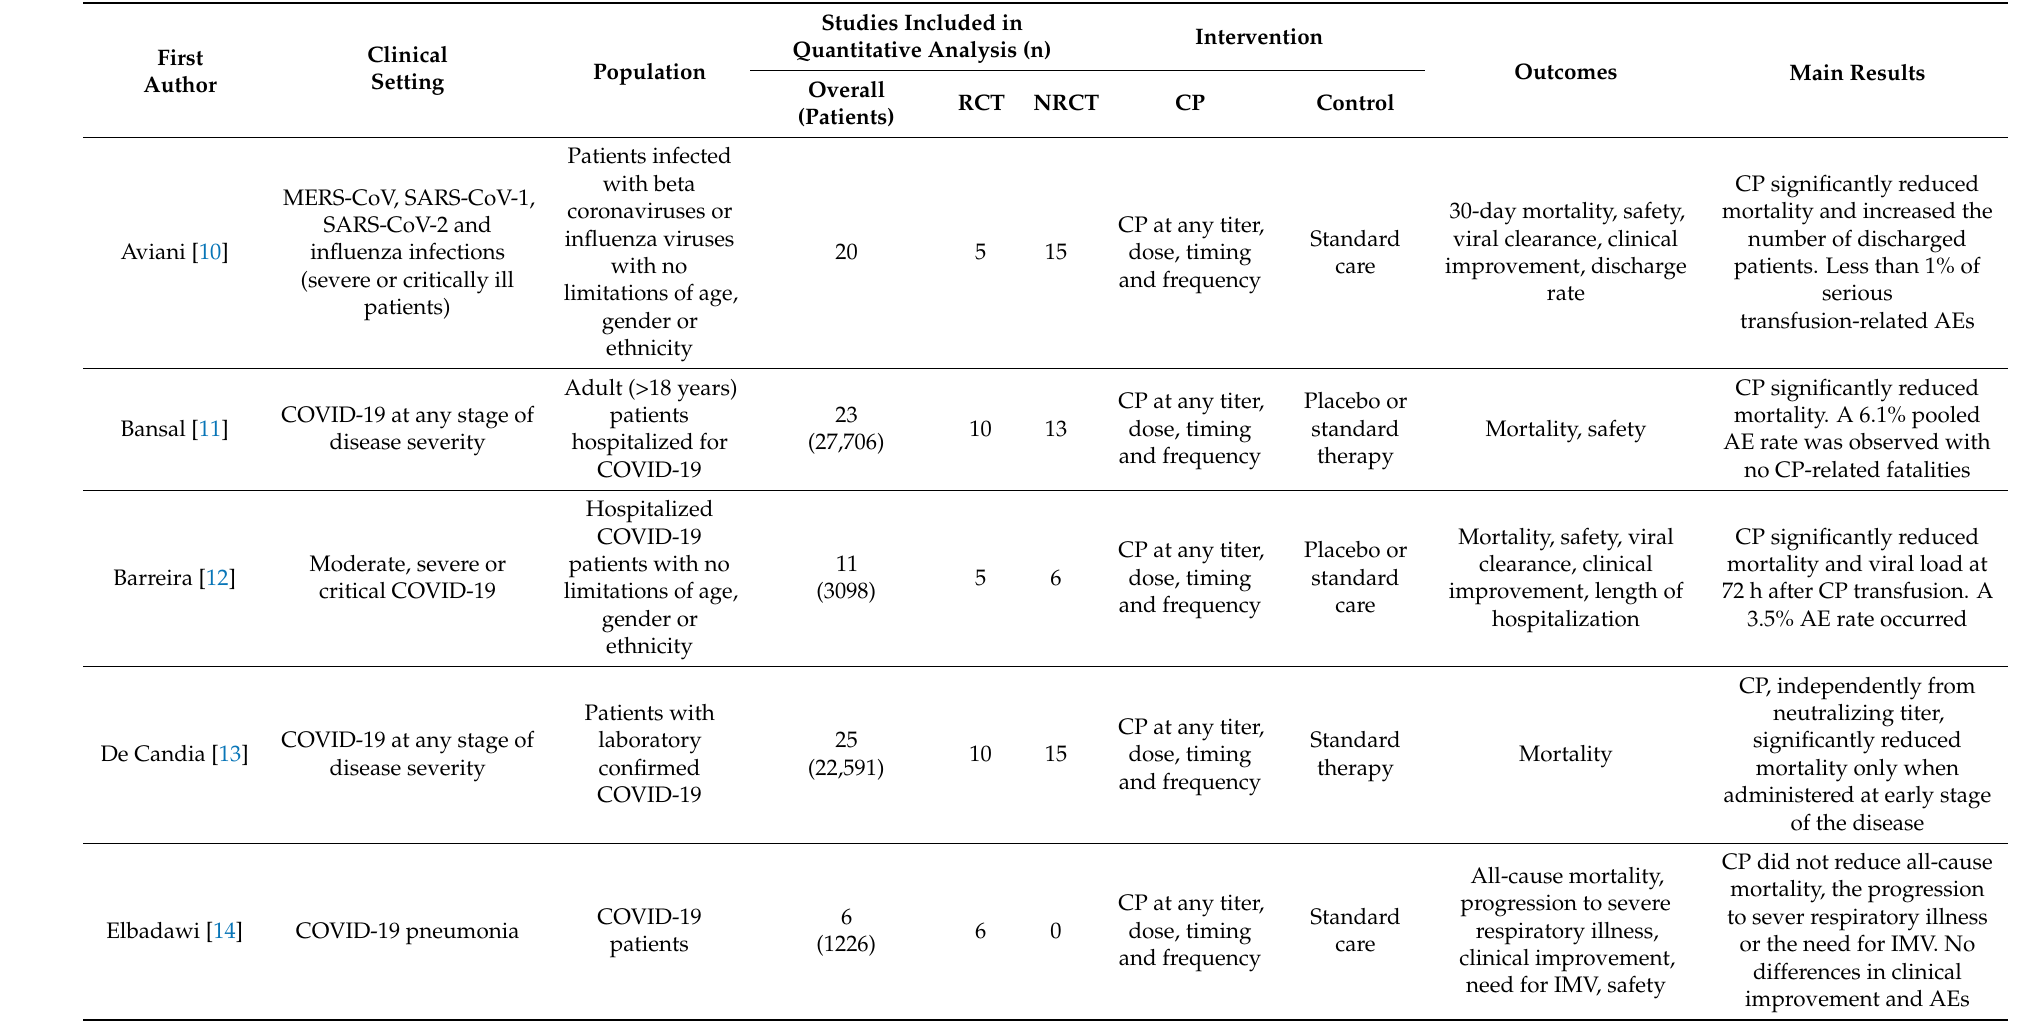
Table 1. Summary of the published systematic reviews and